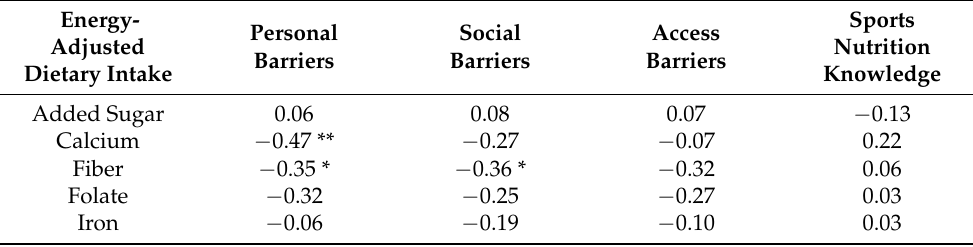
Table 5. Correlations between dietary intakes and perceived barriers, as well as sports nutrition knowledge (N =